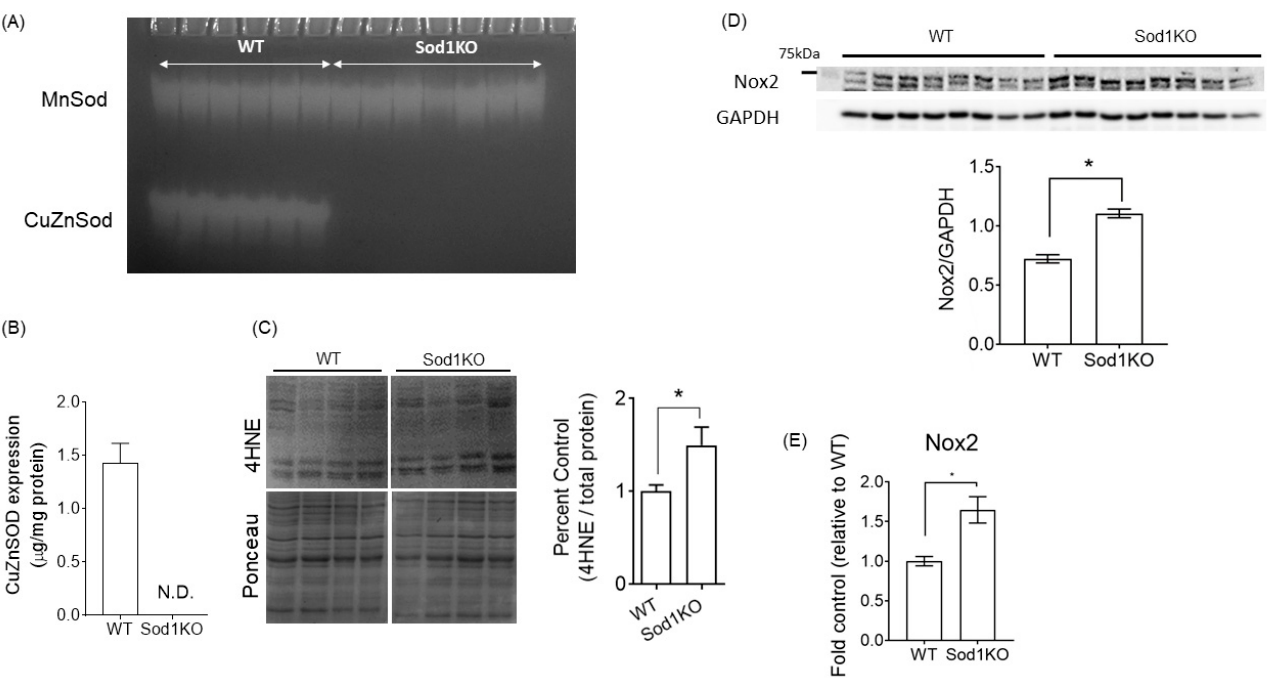
Figure 1. Elevated oxidative modifications in mouse hearts lacking superoxide dismutase1, Sod1 knockout or Sod1KO. ( A ) Activity gel for CuZnSOD enzyme in heart lysates from WT and Sod1KO mice ( n = 6–8). ( B ) CuZnSOD protein contents determined by targeted mass spectrometry ( n = 7–8). ( C ) Top: Representative blot images of molecular weights 150–40 kDa. Bottom: Quantification of the 4HNE products in heart lysates ( n = 7–8). Entire lanes were quantified to determine the 4HNE-conjugated proteins. ( D ) Expression of Nox2 proteins and ( E ) mRNA expression, determined by qRT-PCR in the heart lysates of WT and Sod1KO mice ( n = 8). Data are mean ± SEM. * p < 0.05. Abbreviations: Sod = superoxide dismutase; Nox = NADPH oxidase; 4HNE = 4-Hydroxynonenal.